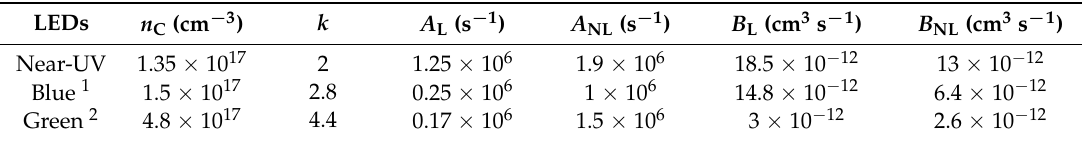
Figure 6. ( a ) CIE; ( b ) RRE; and ( c ) carrier concentration depending on injection current density. Table 1. Fitting parameters of near-UV, blue, and green LEDs.